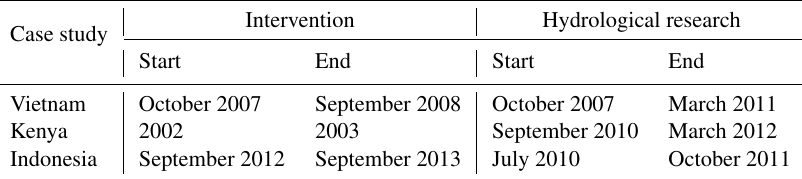
Table 4. Time periods of three hydrological intervention-based research